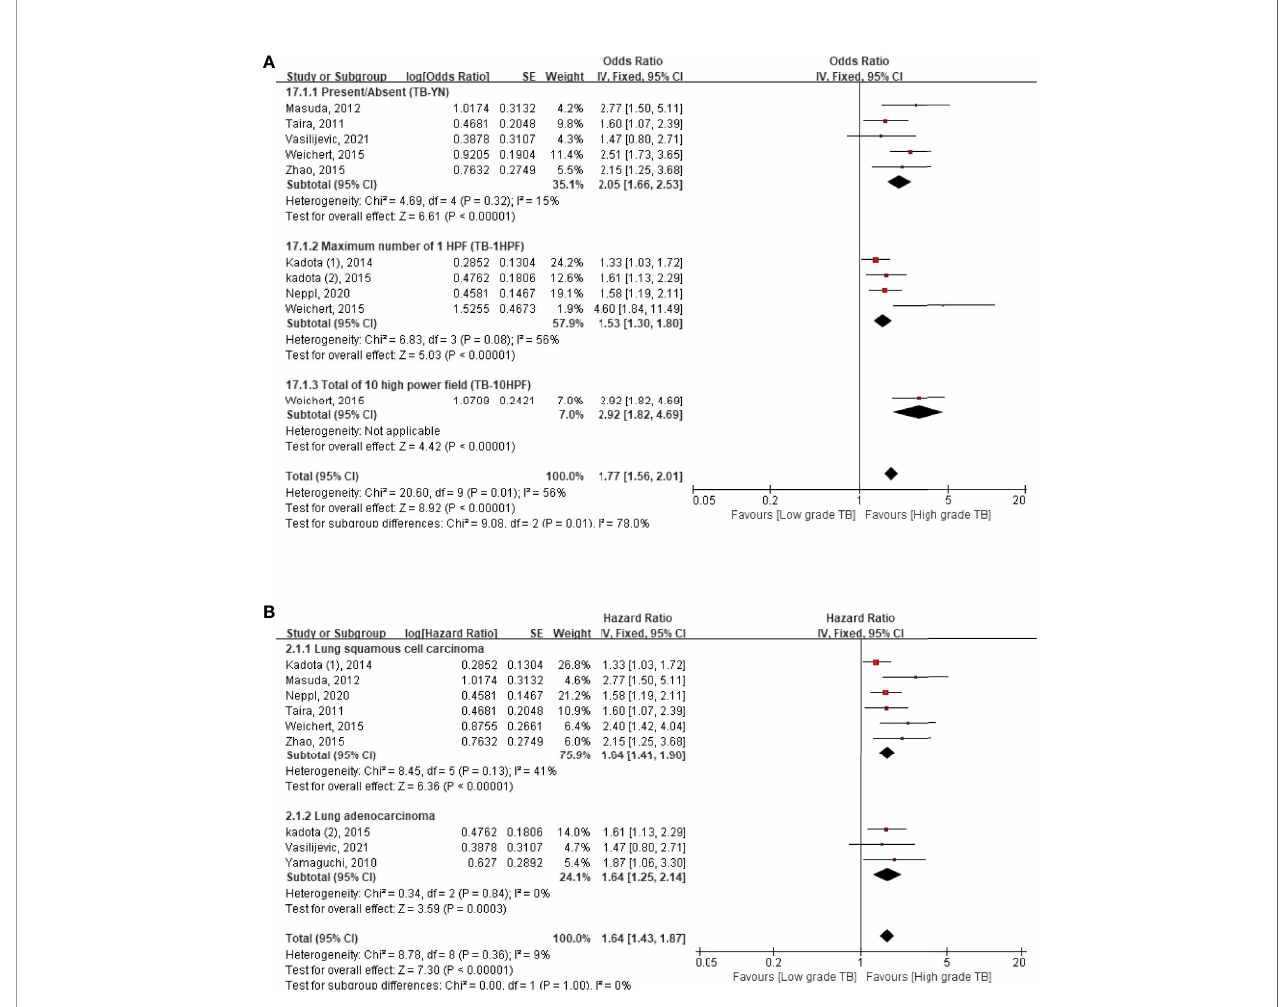
FIGURE 2 | Subgroup hazard ratios analyzing the tumor budding expression for overall survival, by (A) assessment methods and (B) histologic type of lung